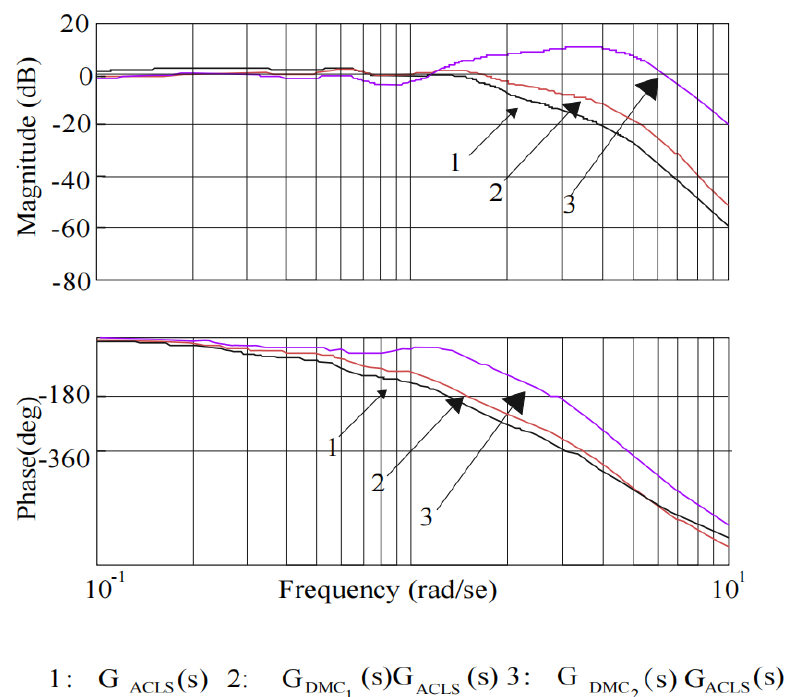
GG s G s () ( ) D M C A L C S A L C S ， where and G ALCS ( s ) G ALCS ( s ) and purple curve 3 is G DMC 2 1